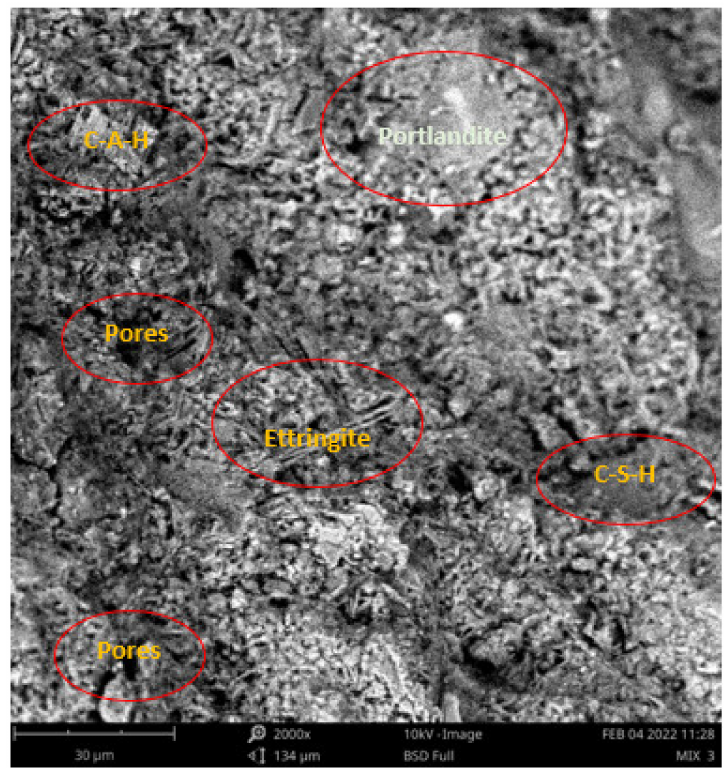
Figure 13. Micrograph of Y 3 concrete specimen.